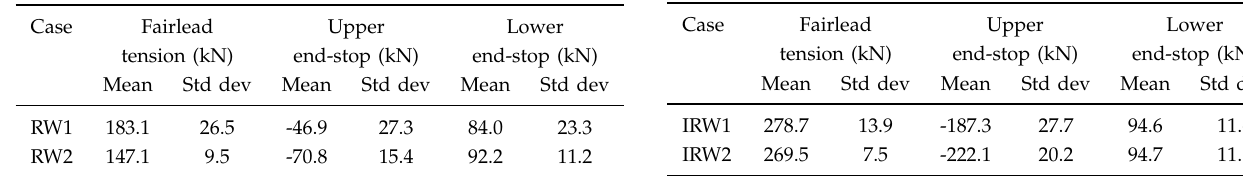
TENSION , UPPER AND LOWER END - STOP FORCES FOR THE RW1 AND RW2 CASE USING d = 5 .